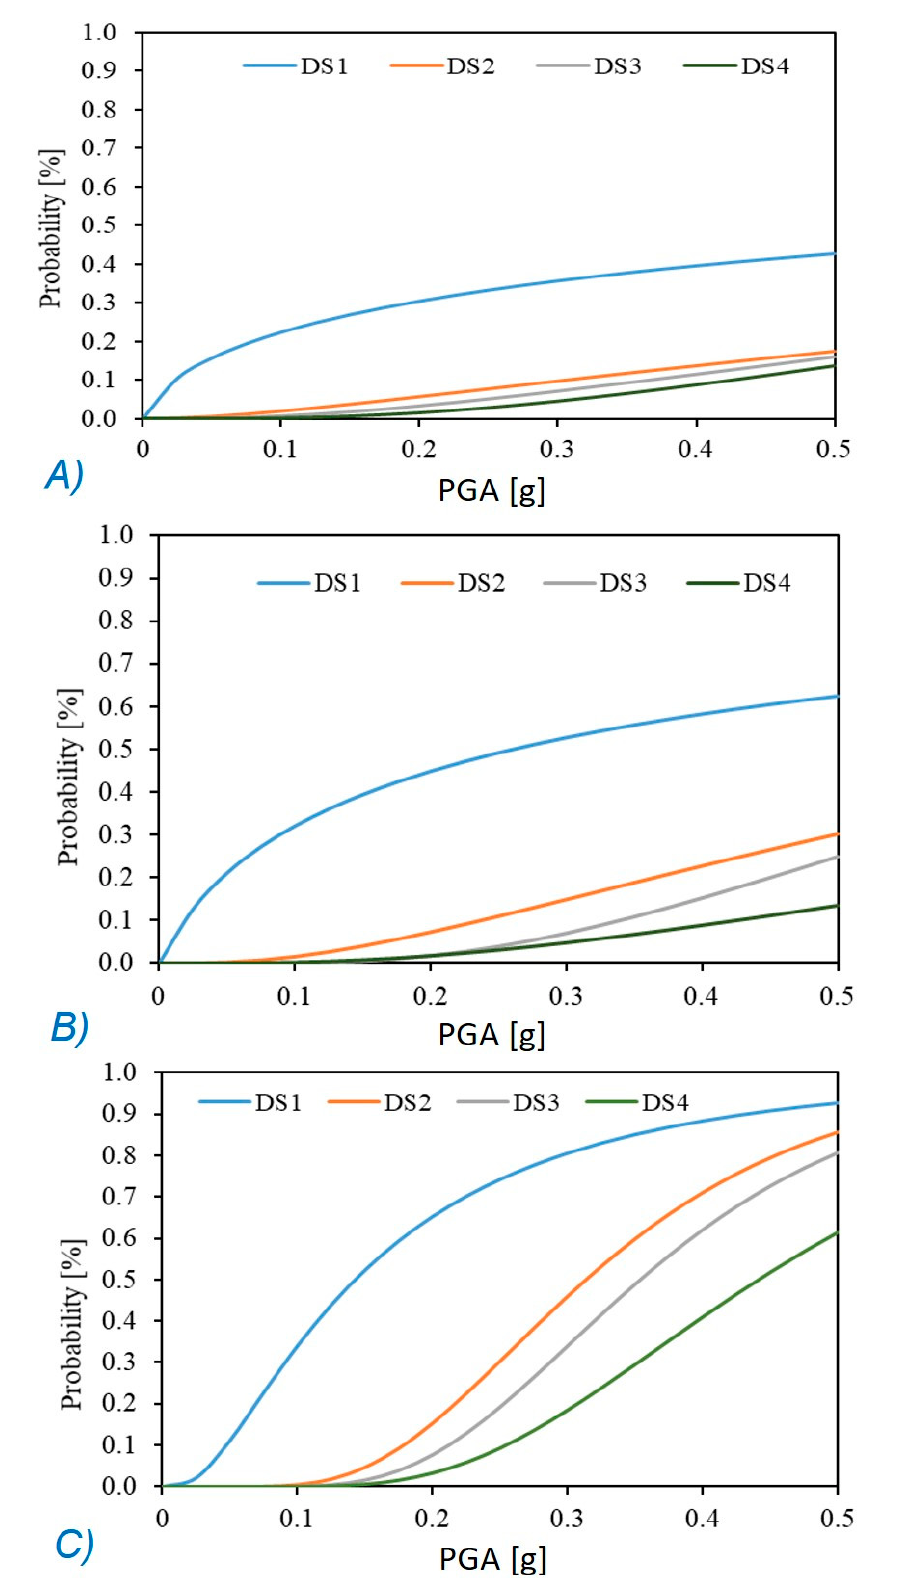
Figure 8. Structural fragility curves for building with 1–3-storeys: ( a ) seismic design; ( b ) no seismic Figure 8 design; ( c ) no seismic design